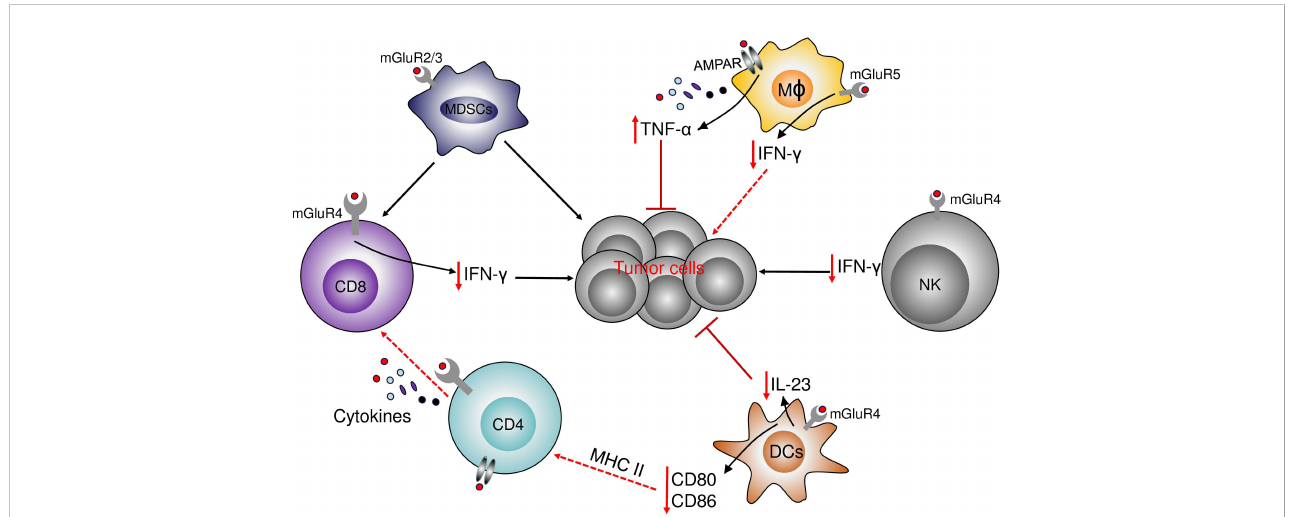
FIGURE 5 The role of glutamate receptors in immune cells. The activation of mGluR4 on the surface of DCs decreases the production of the protumor IL-23 and decreases tumor growth. mGluR4 also increases the expression of CD80 and CD86. In NK and T cells, the activation of mGluR4 decreases the antitumor immune response by the decrease in NK and T cells in fi ltration and the decrease in IFN- g production. In Myeloid-derived suppressor cells (MDSCs), the activation of mGluR2/3 decrease the immune-suppressive properties of MDSCs on T cells and decreases the effects of MDSCs in cancer cells. In macrophages, the activation of mGluR5 increases the level of PPAR- g and a shift from M1 to M2 phenotype and the decrease in IFN- g production, while the activation of NMDAR increases the production of TNF- a